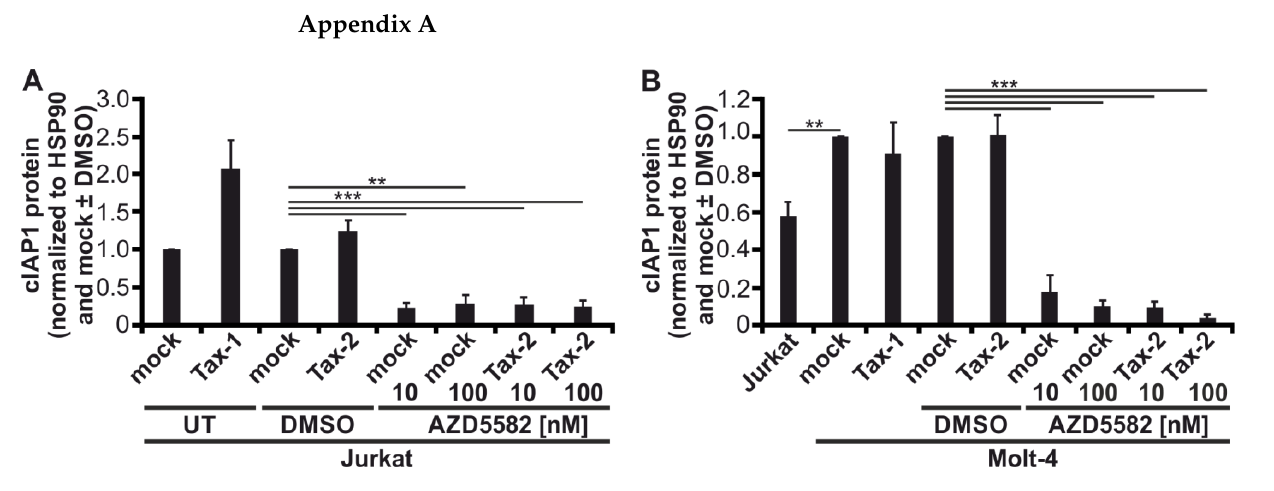
Figure A1. The second mitochondria-derived activator of caspases (SMAC)-mimetic AZD5582 leads to robust degradation of cellular inhibitor of apoptosis 1 (cIAP1). ( A ) Jurkat or ( B ) Molt-4 T-cells were transfected with pEF-Tax-2, the mock control vector pEF-1 α , or pEF-Tax-1 as positive control (100 µg). After 24 h, cells were treated with two concentrations of AZD5582 (10 or 100 nM) or dimethyl sulfoxide (DMSO) as solvent control for up to 48 h or were left untreated (UT). Immunoblots are shown in Figure 7A (Jurkat) and Figure 7D (Molt-4). Densitometric analysis was performed to quantify cIAP1 protein. Values were normalized to HSP90 and pEF-1 α (mock) with or without DMSO as indicated, and the means of ( A ) four or ( B ) three independent experiments ± SE were compared using Student’s t test (** p < 0.01, *** p < 0.001).